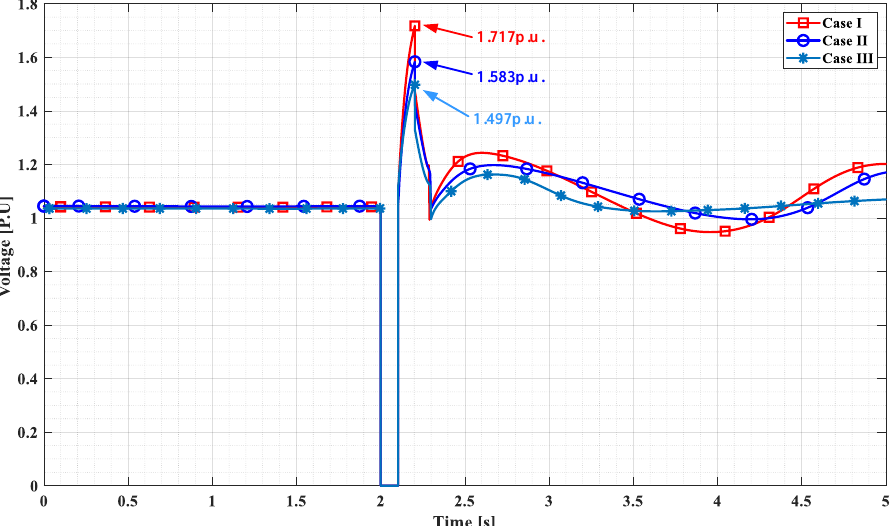
Figure 7. RMS-based TSA simulation results for screening study to obtain violated